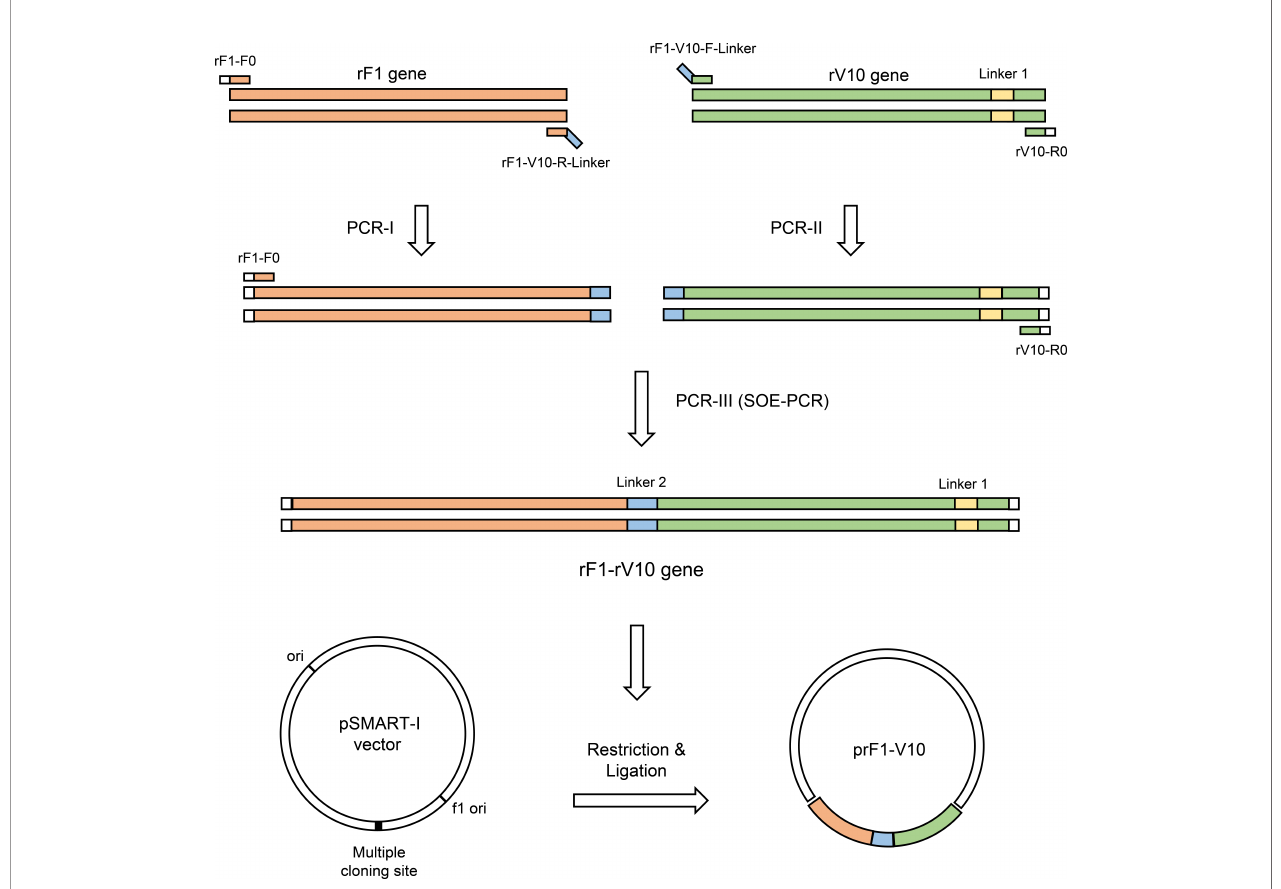
FIGURE 1 | Schematic representation of PCR ampli fi cation, splicing and cloning of chimeric rF1-V10 gene in pSMART-I